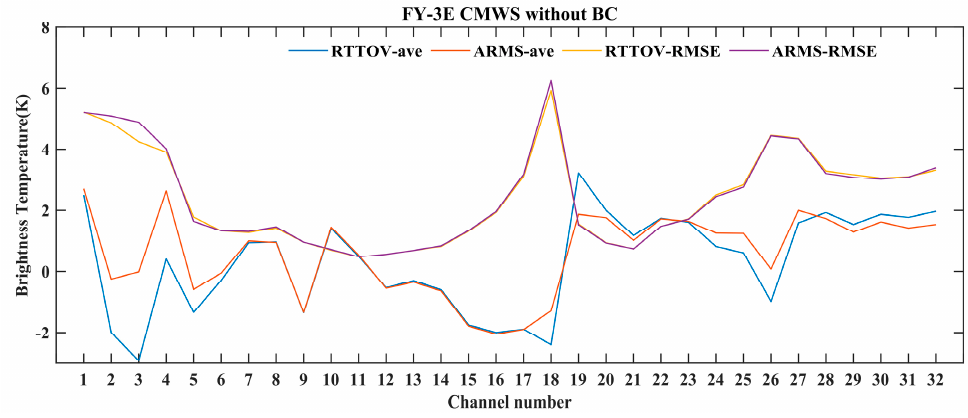
Figure 9. The average bias and RMSE of simulated and observation of FY-3E CMWS data using ARMS, along with the results of RTTOV.